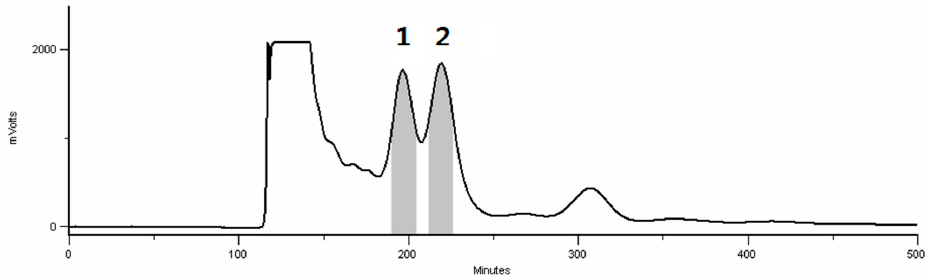
Figure 3. Chromatograms of HSCCC obtained from the diarylheptanoid-rich fractions of B. platyphylla using the two-phase solvent system ethylacetate–acetonitrile–water 1:0.1:1 ( v / v / v ). The stationary phase was the upper phase, the mobile phase the lower phase, and the flow rate was 1.5 mL/min. The revolution speed was 1000 rpm. The sample size was 100 mg, and the separation temperature 25 °C.